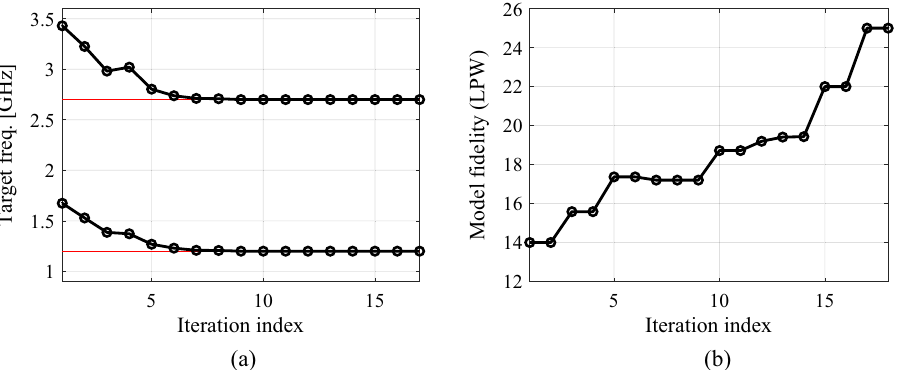
Figure 11. Dual-band branch-line coupler: ( a ) history of the target operating frequency (horizontal lines mark the initial targets); ( b ) evolution of the model resolution.